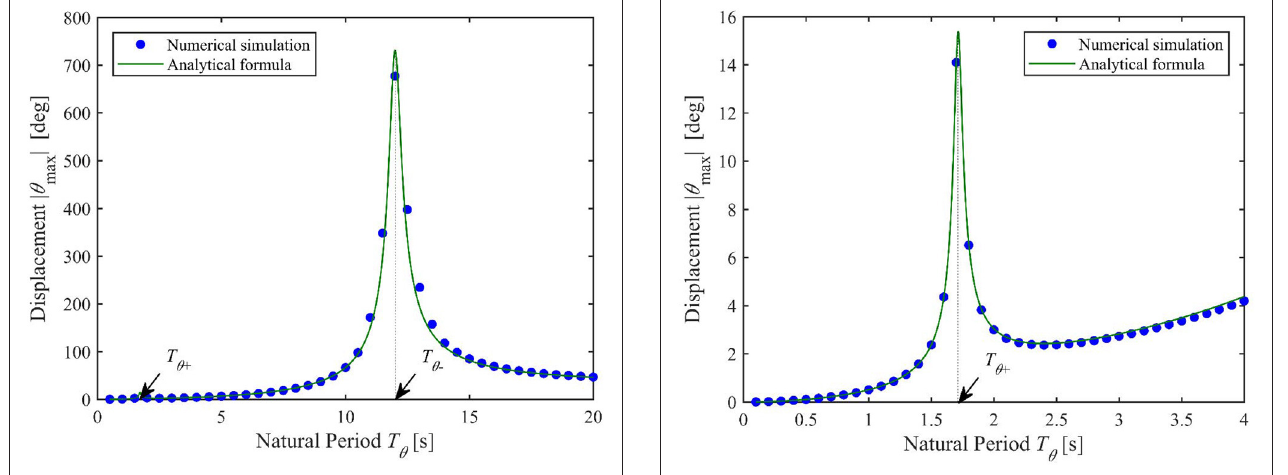
FIGURE 3 | Relation between the maximum displacement of torsional θ max response and the natural period of torsional mode T θ . | |